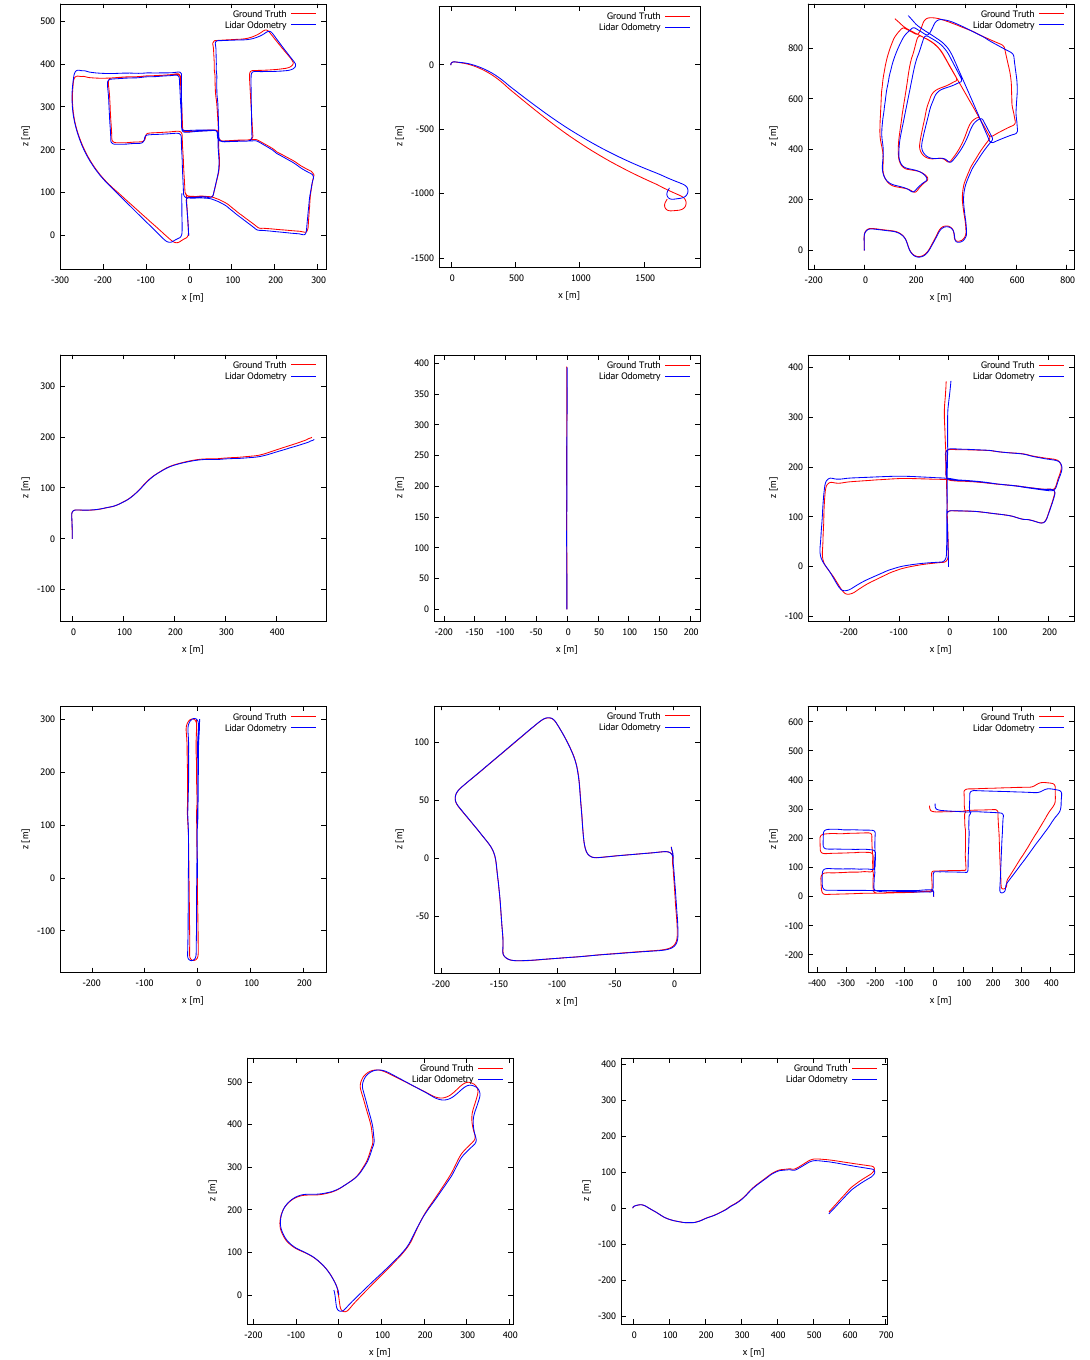
Figure 18. Eleven plots of the estimated (blue) and ground truth (red) trajectories of the Kitti benchmark presented in [27]. The sequences “00” to “10” are presented from left to right and from top to bottom. The algorithm was run without the loop detection and closure algorithm. The majority of the results are